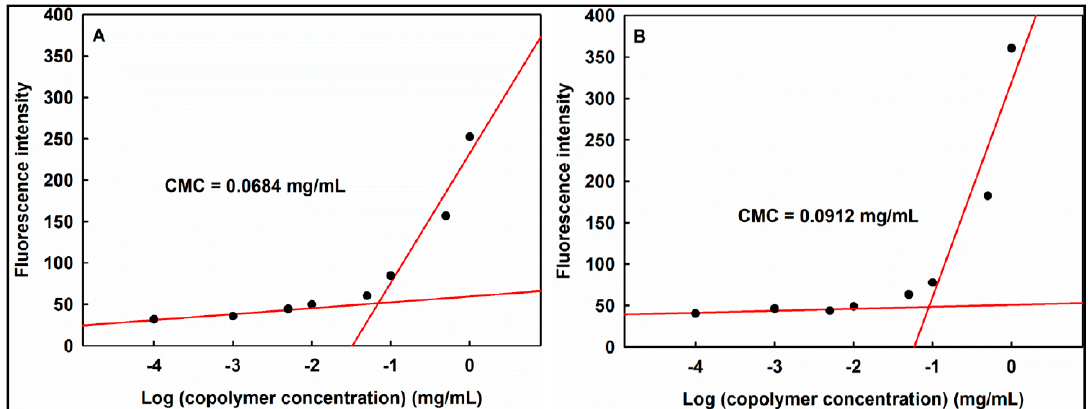
Figure 6. Nile red fluorescence intensity versus logarithmic copolymer concentration. Copolymer was P(HEA- co -PVS)(97/3) ( A ) and P(HEA- co -ABZ) ( B ).